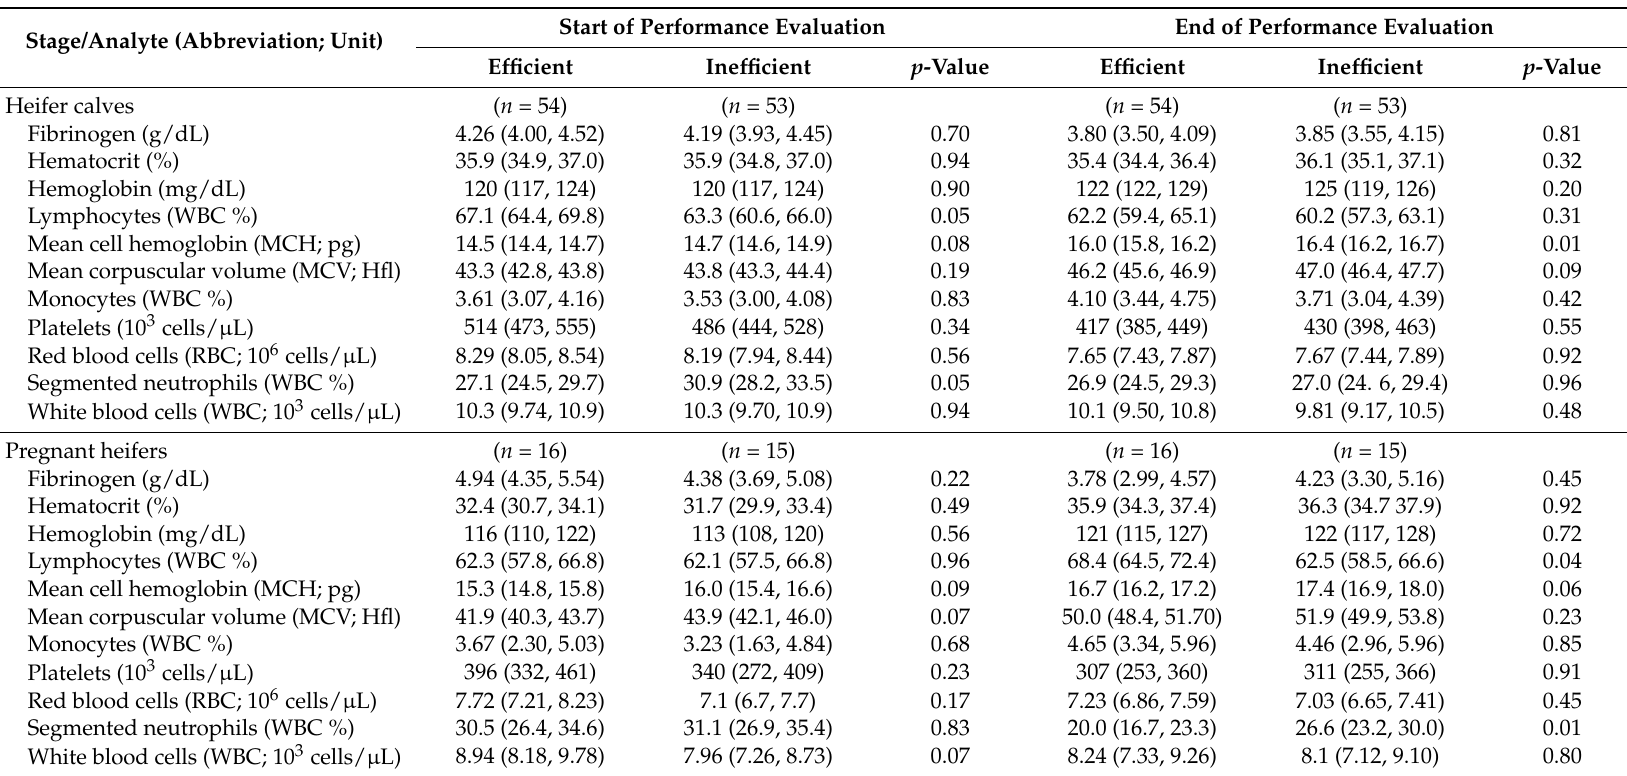
Table 2. Blood cell count least square means (confidence interval) by feed efficiency group of both developmental stages at the start and end of the test. Stage/Analyte (Abbreviation;